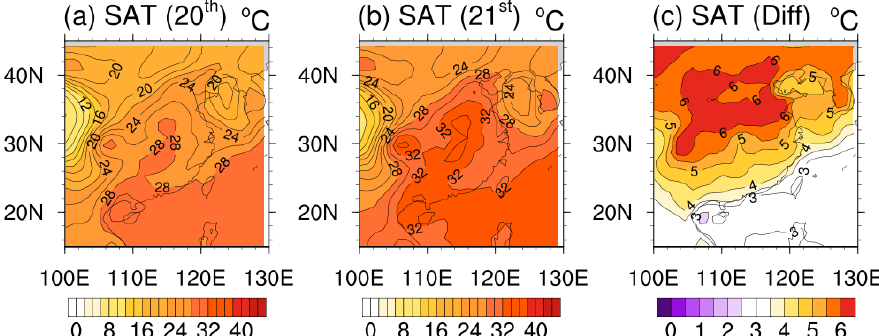
Figure 5. SAT (°C) changes in southeastern China at the end of the 21st century under future sce- narios (Representative Concentration Pathways 8.5 (RCP8.5)): ( a ) late 20th century, ( b ) late 21st century, ( c ) difference between the two periods.